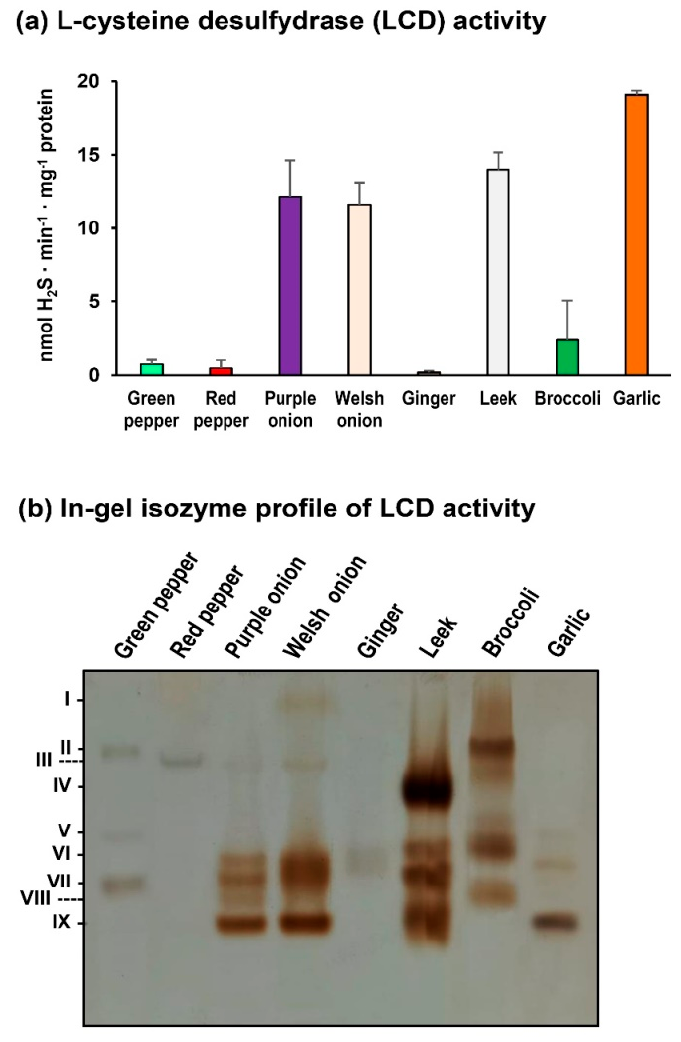
Figure 3. L-Cysteine desulfhydrase (LCD) activity in different plant samples. ( a ) Spectrophotometric assay. ( b ) In-gel isozyme profile of LCD activity. Protein samples (74 µ g protein per lane) were separated by non-denaturing polyacrylamide gel electrophoresis (PAGE; 8% acrylamide) and the LCD activity was detected by lead acetate staining (see M&M for